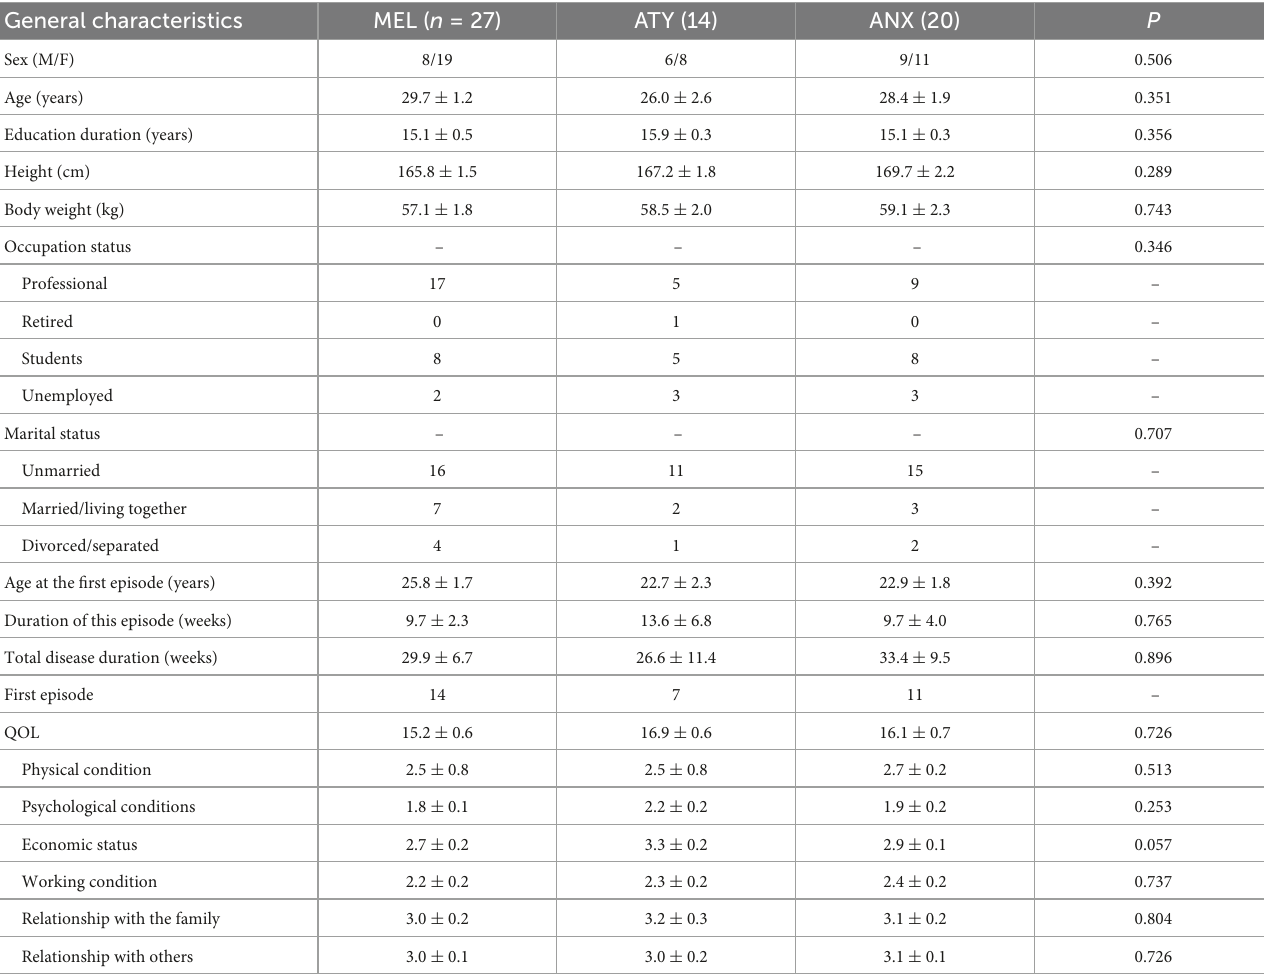
TABLE 1 Comparison of the baseline